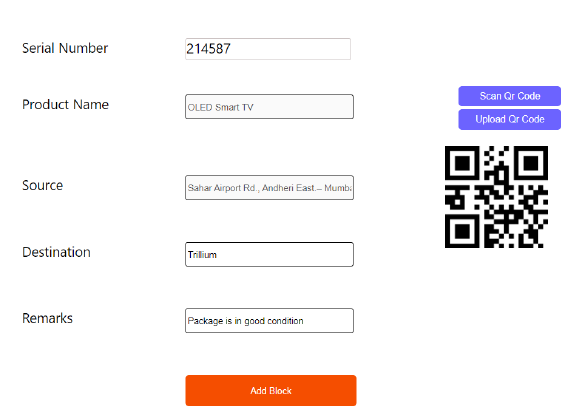
Figure 14: Supplier adding details for the product.